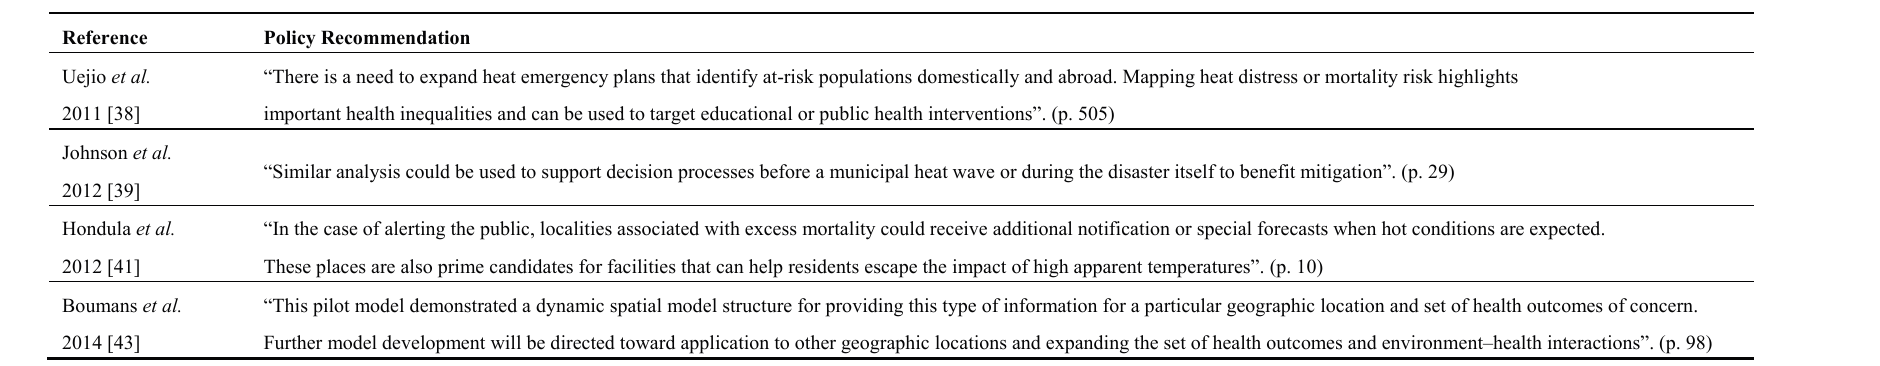
Table A3. Policy recommendations on mapping health outcomes and exploring vulnerability